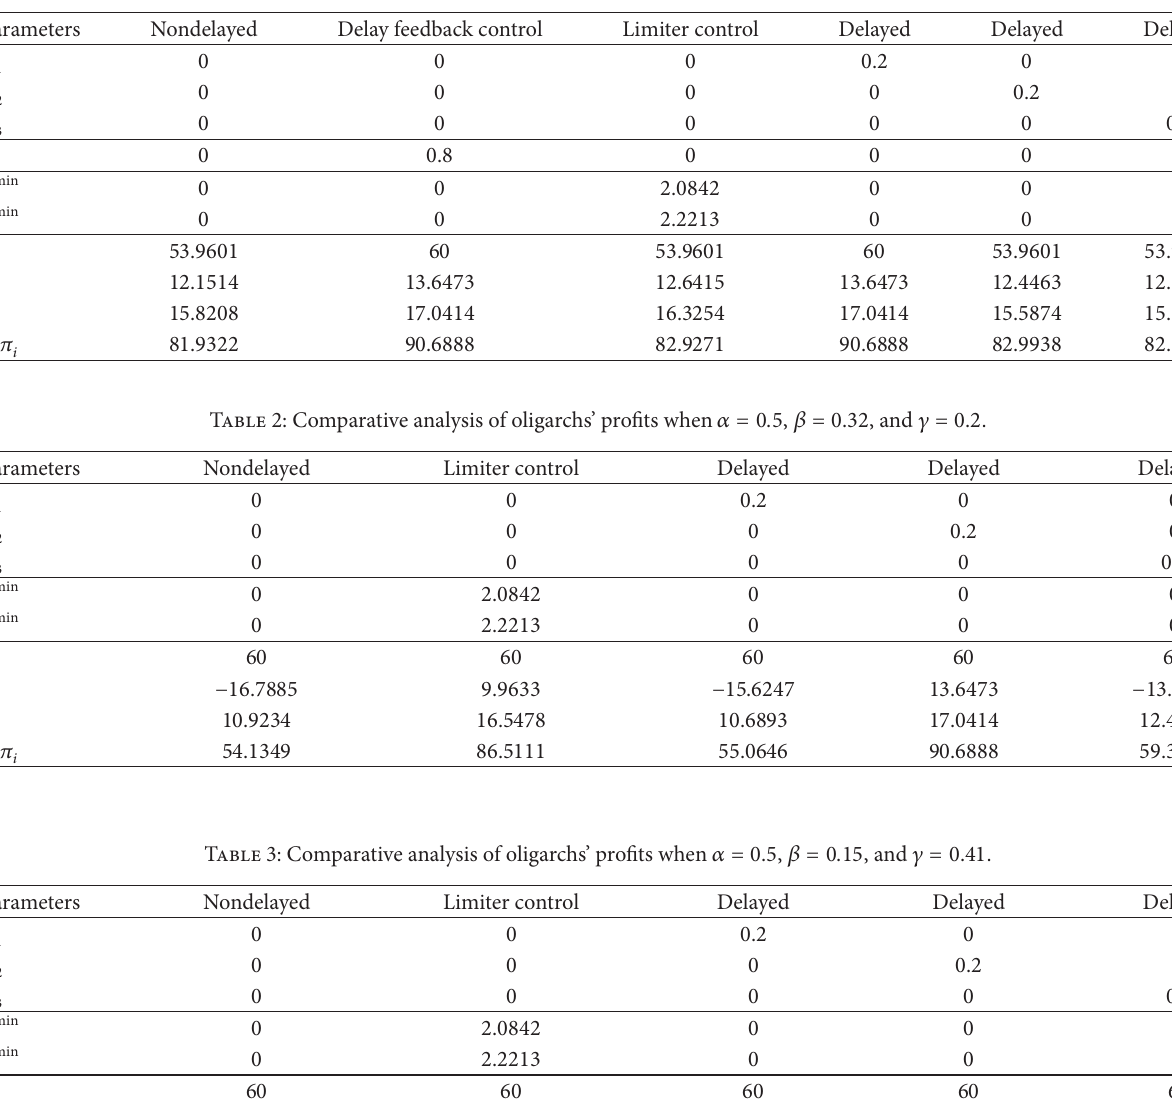
Table 1: Comparative analysis of oligarchs’ profits when 𝛼 = 1.36 , 𝛽 = 0.15 , and 𝛾 = 0.2 .